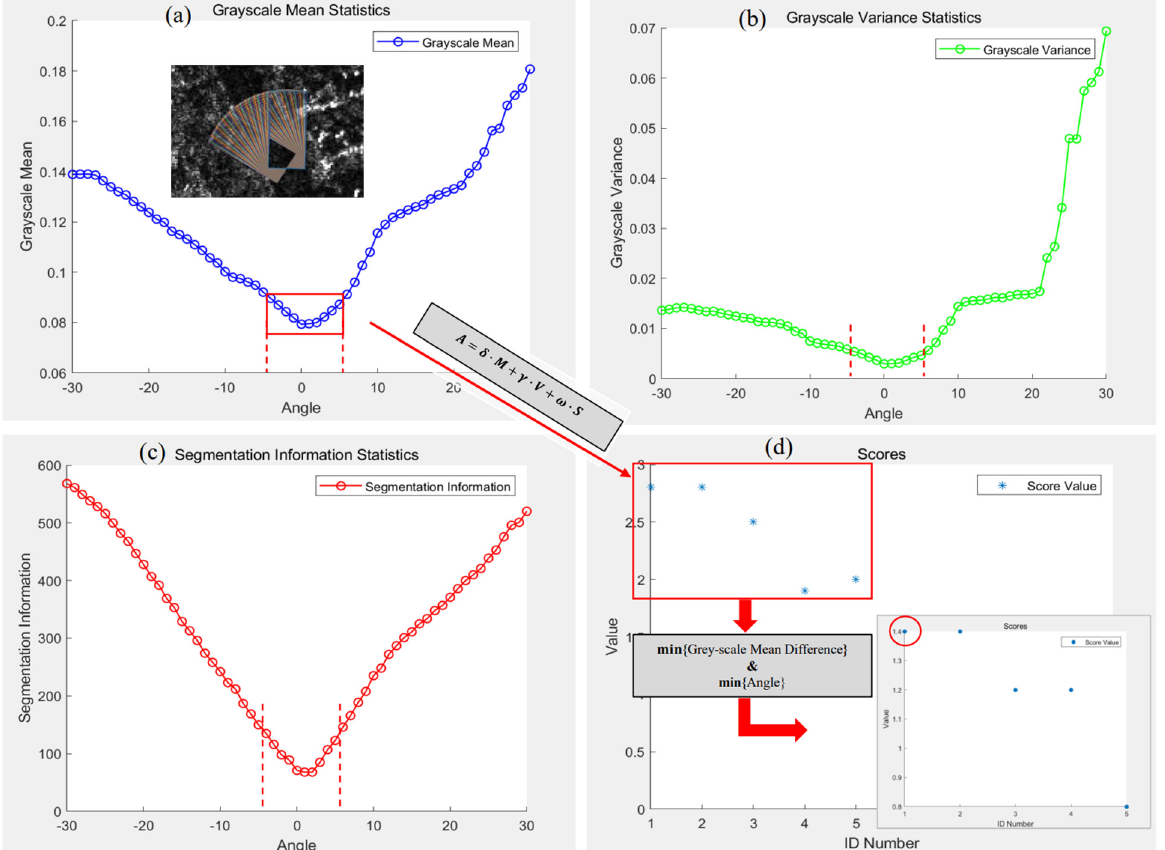
Figure 4. Identifying the best window based on the overall metric considering grayscale mean, grayscale variance, and binary segmentation information.